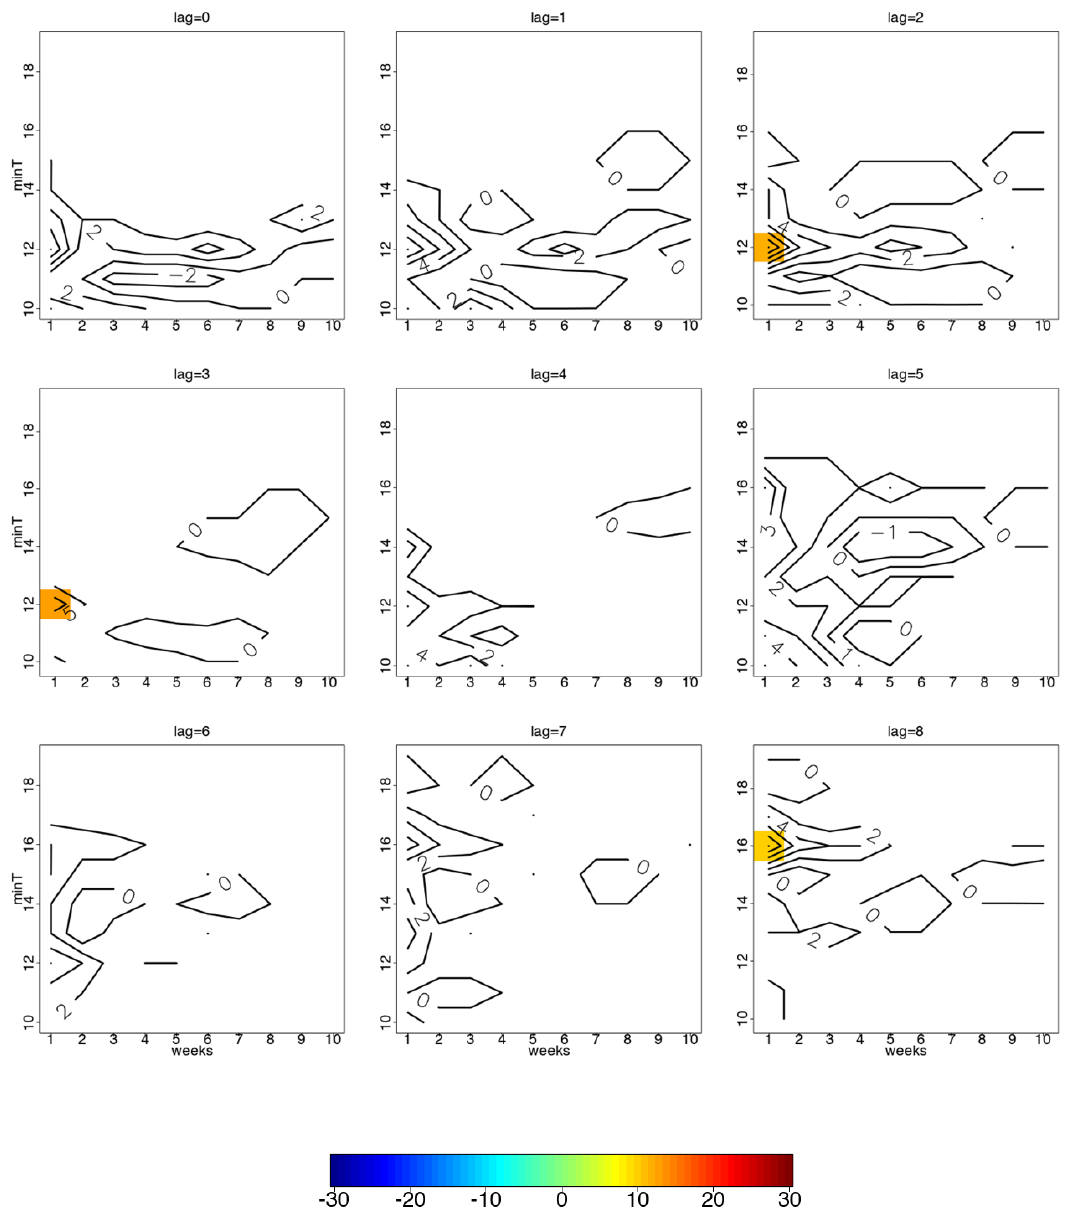
Figure 8. Statistically significant contour differences in anomalously high and low diarrhoea case counts for lag 0 to 8 weeks per consecutive weeks of minimum temperature among individuals under 5 years of age for season JJA. X-axis represents number of consecutive weeks in which the average temperature reached over Y-axis representing temperature in degrees Celsius (°C). Warm colours represent higher frequency of (X, Y) occurring when diarrhoea case counts were anomalously higher than average.